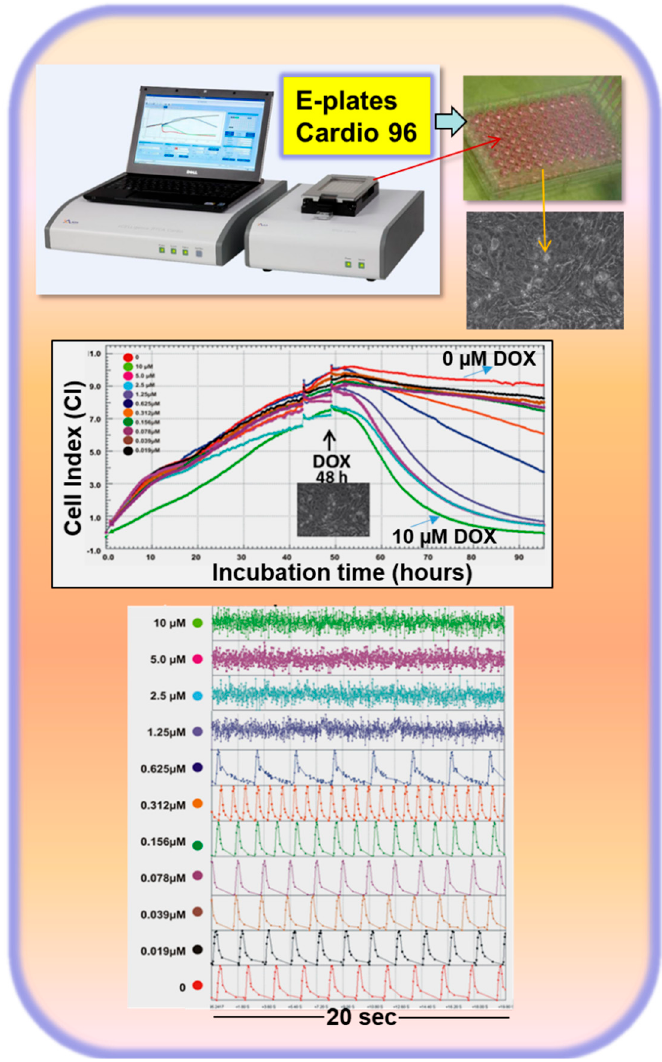
Figure 1. Identification of the minimal function affecting concentration (MIFAC) of doxorubicin (DOX). MIFAC is defined as a concentration affecting the function of human-induced pluripotent stem cell (hiPSC)-derived cardiomyocytes (CMs) (the beating activity) without cytotoxic effects. The so-called MIFAC concentration was determined using the xCELLigence Real-Time Cell Analyzer (RTCA) cardio system to detect DOX-induced cytotoxicity while also monitoring functional alterations of hCM by measuring the beating frequency and cell death of CMs in real time (Figure 1) [37–39,41] .